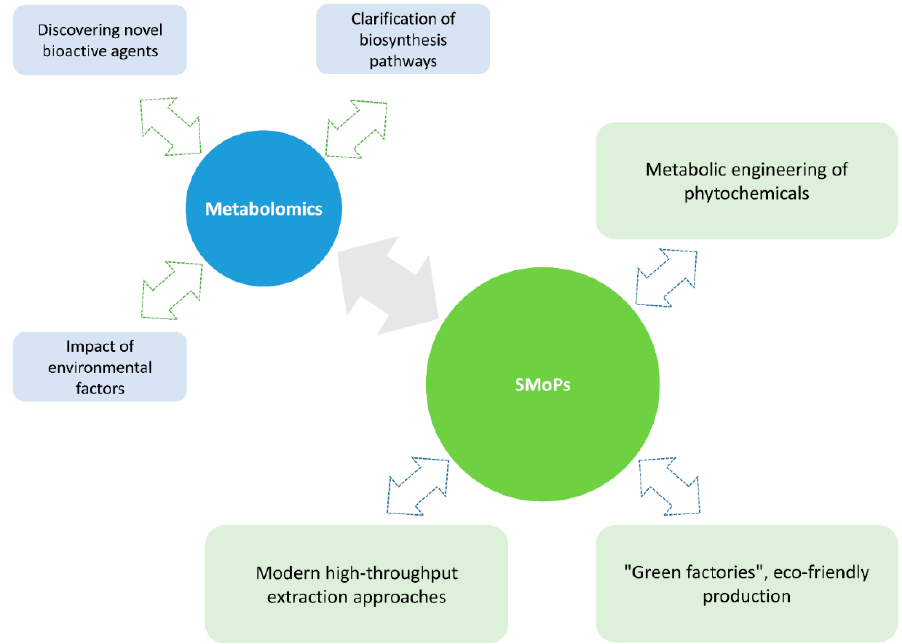
Figure 1. Herbal manufacture in the twenty first century.